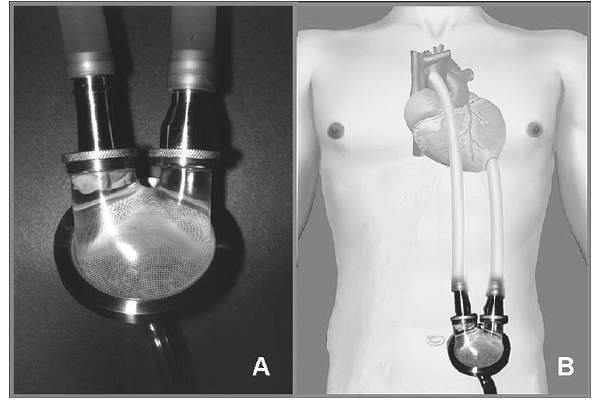
Fig. 1 - Fotografia (A) e representação esquemática (B) do dispositivo paracorpóreo de assistência ventricular InCor, implantado como suporte circulatório em paralelo aos ventrículos direito e